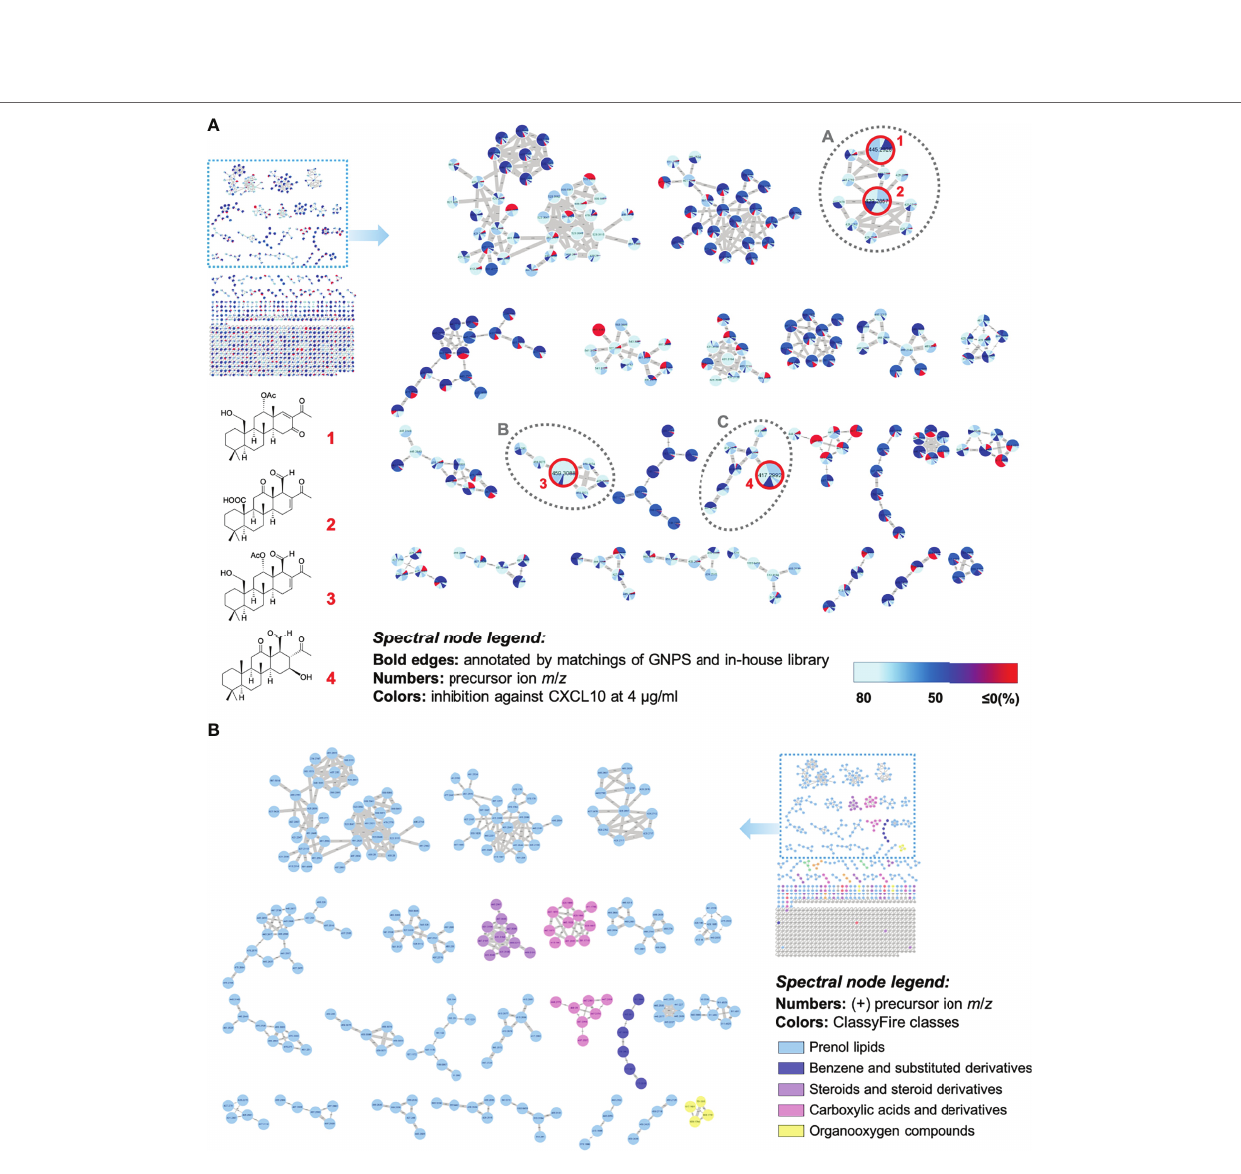
FIGURE 4 | The multi-informative MN illustrated the relationships between scalarane diversity and anti-neurofibroma property in the Lendenfeldia sp. sponge extract. (A) The constructed MIMN is based on the inhibition of CXCL10 expression (4 μg/ml) in CRL-3390 cells; (B) the molecular network spectral nodes are colored according to ClassyFire